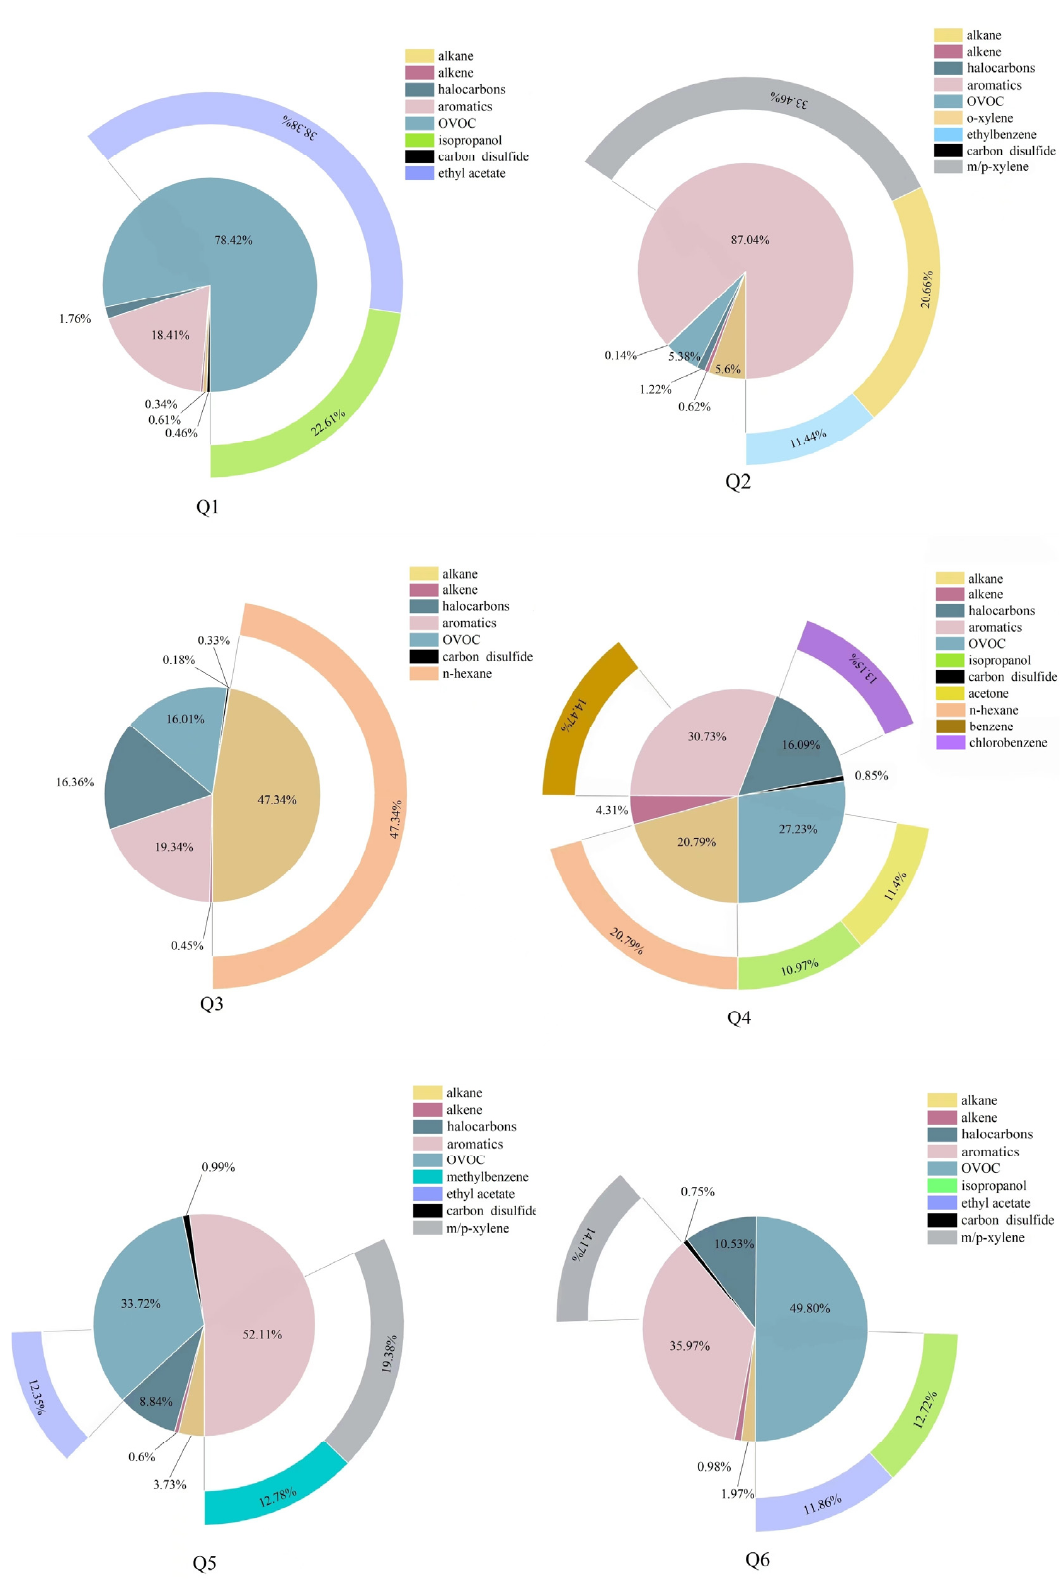
Figure 3. Percentage of characteristic pollutants.